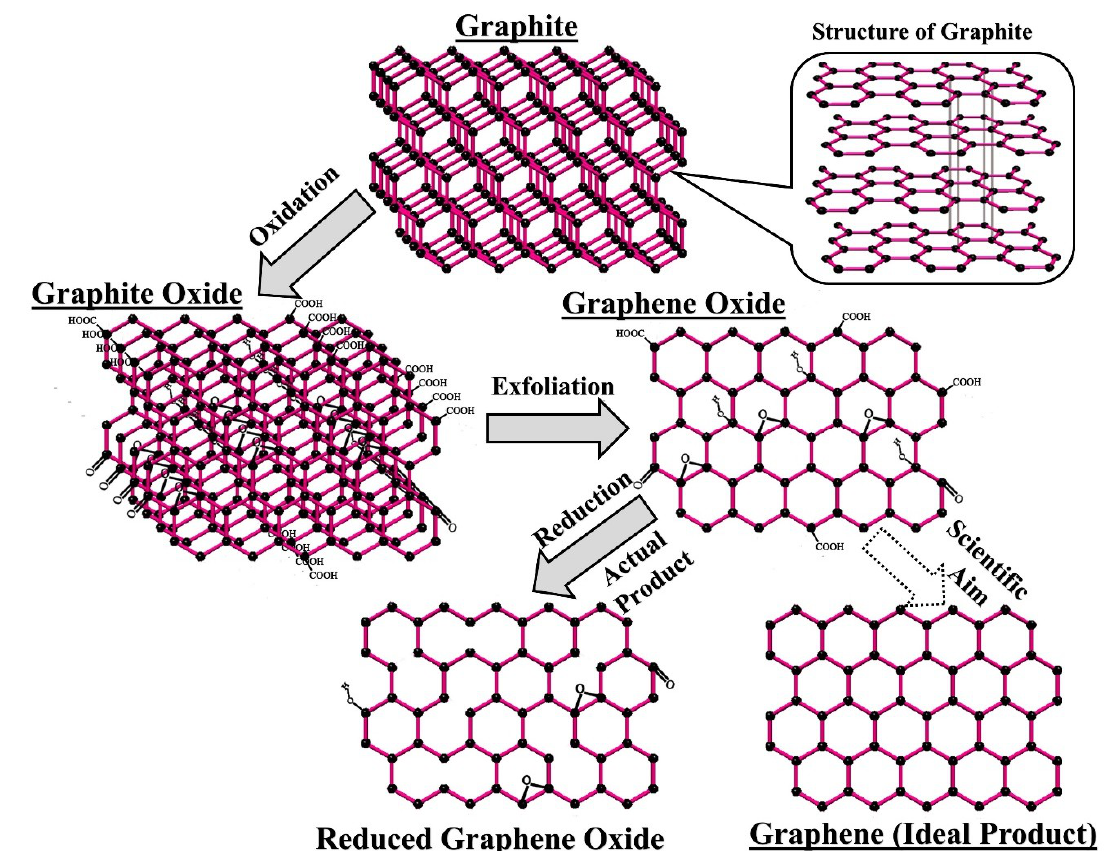
Figure 7. Scheme for making graphene oxide and reduced graphene oxide from graphite.